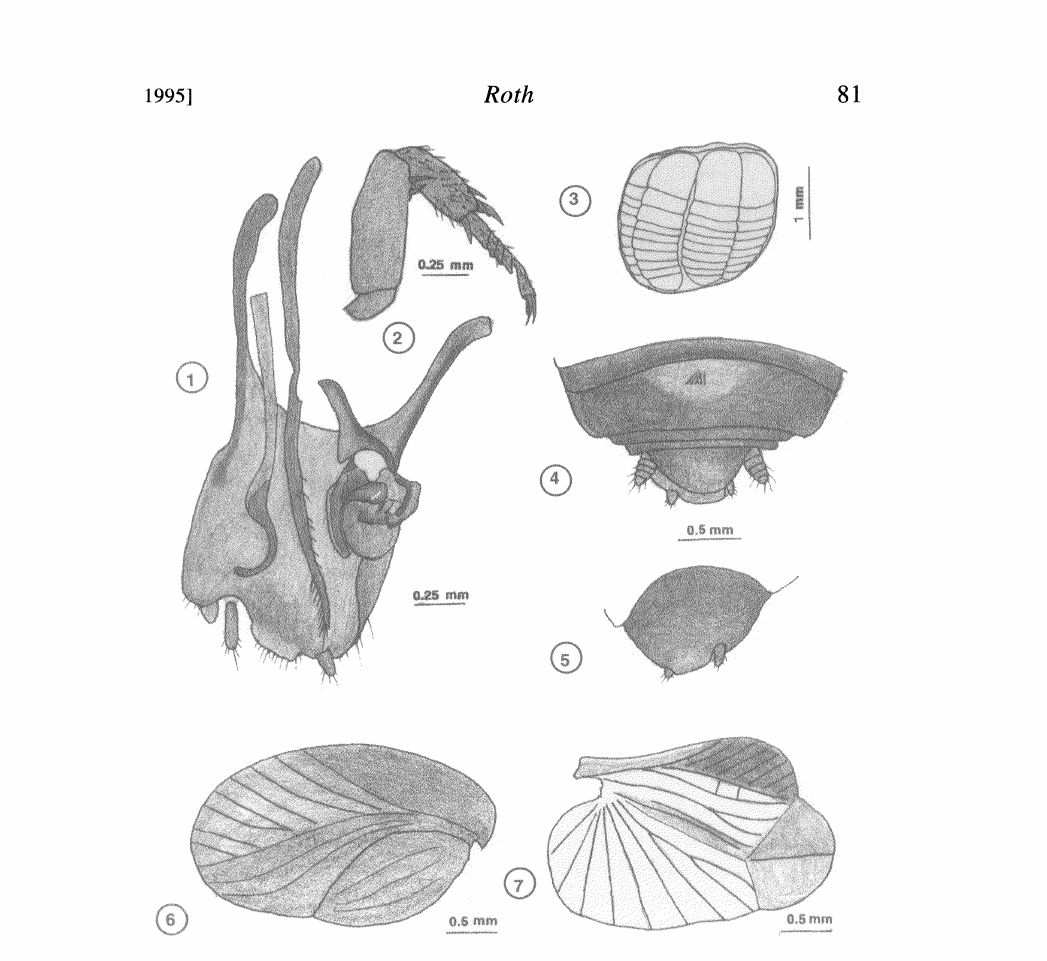
Figs. 1-7. Pseudoanaplectinia yumotoi Roth, from Sarawak (paratypes). 1,2,4,5, males; 6,7, female. 1. subgenital plate and genitalia (dorsal); 2. front leg (anterior surface; note only 2 distal spines on the ventral margin); 3. ootheca removed from a female abdomen; the embryos are well developed and show segmentation; eyes are present but not visible in this view; 4. terminal abdominal segments (dorsal); 5. subgenital plate (ventral); 6. tegmen; 7. hind wing. Pairs of adult paratypes (c and 9) have been deposited in ANSP, HECO, NMVA, NRSS, and